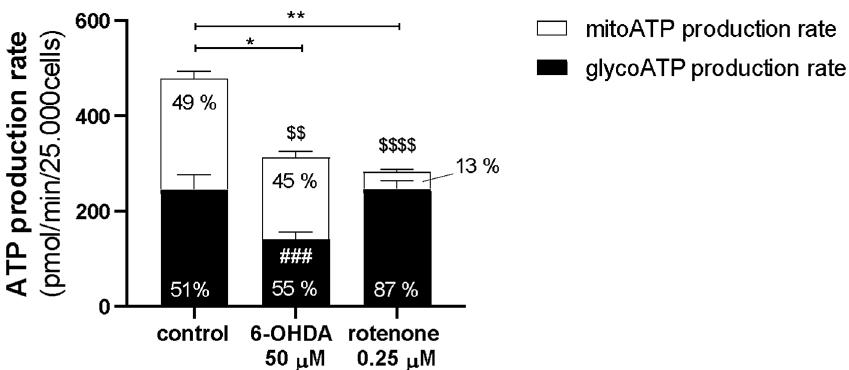
Figure 6. Acute treatments with 50 µ M 6-OHDA and with 0.25 µ M rotenone decreased total ATP levels in distinct manners. Cells acutely incubated with 50 µ M 6-OHDA and with 0.25 µ M rotenone exhibited a decrease in total ATP levels. Black bars represent glycoATP production rate, while white bars represent mitoATP production rate. Data are presented in columns representing the Mean ± SEM of 8 independent cell populations. Kruskal–Wallis test (one-way ANOVA on ranks) pairwise (control vs. 6-OHDA or control vs. rotenone) was used to assess statistical significance of total ATP levels, (*) p < 0.05, (**) p < 0.01. Additionally, two-way ANOVA with Sidak’s multiple comparisons test was used to assess statistical significance of mitoATP production rate (control vs. 6-OHDA or control vs rotenone) ($$) p < 0.01, ($$$$) p < 0.0001, and glycoATP production rate (control vs. 6-OHDA or control vs. rotenone), (###) p < 0.001.